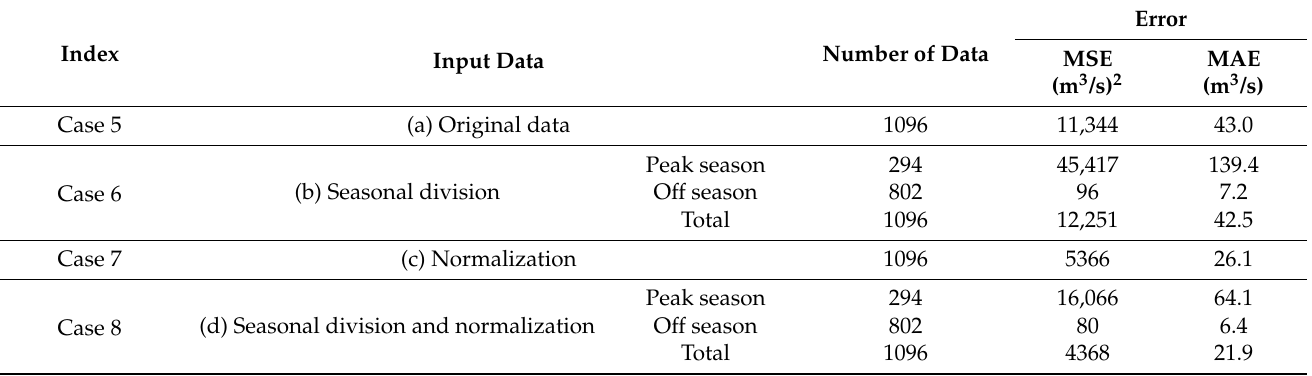
Table 10. Comparison of seasonal division effect.